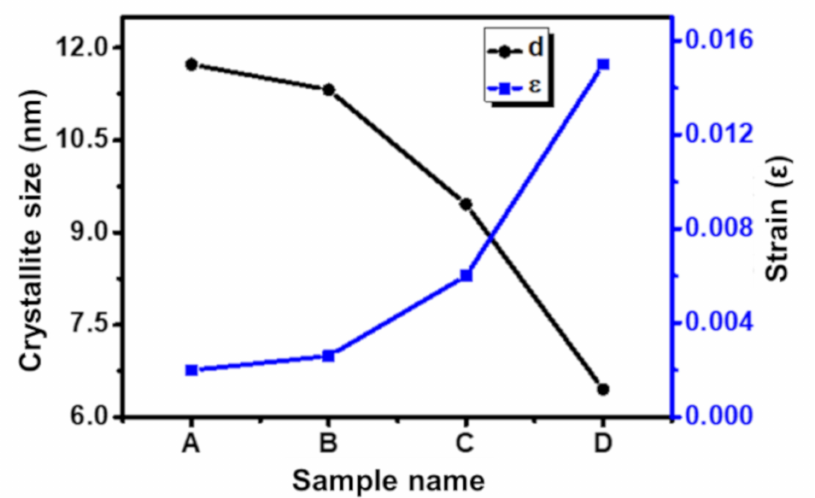
Figure 4. Variation of crystallite size and induced strain for different AMF samples prepared at different precipitation